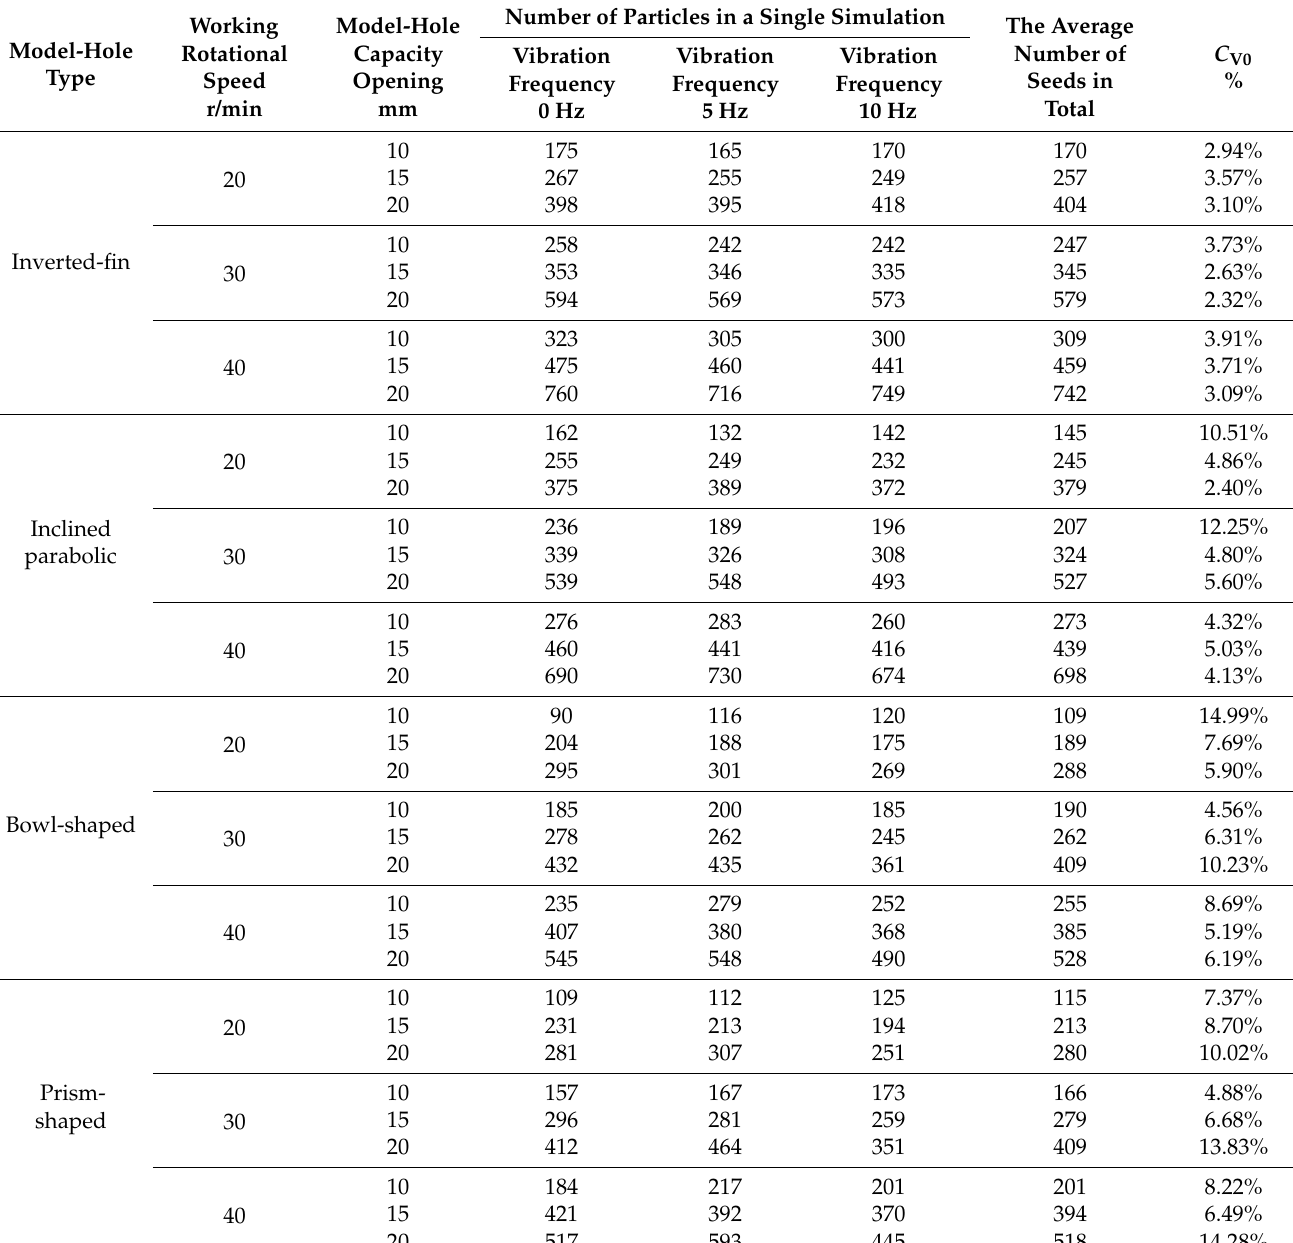
Table 4. Numerical simulation results of seed filling performance of model-hole